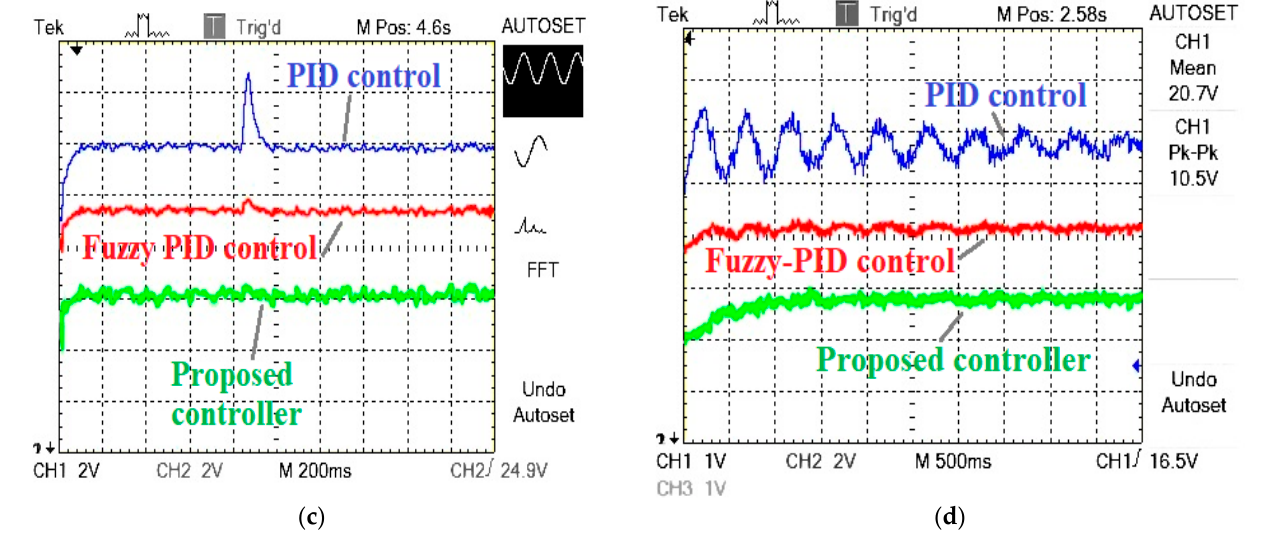
Figure 23. PIL validation for proposed controllers: ( a ) the PIL setup with MATLAB and TMS320 DSK platform, ( b ) validation of Figure 10 (a,c), ( c ) validation of Figure 10(b,d), ( d ) validation of Figure 10c.